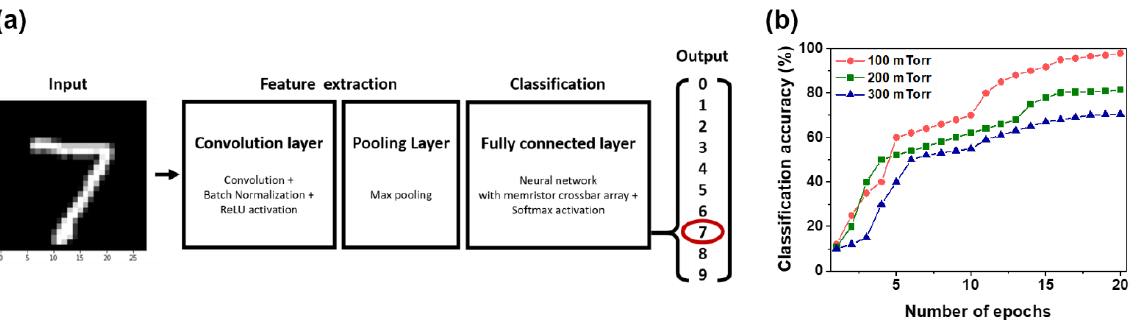
Figure 6. ( a ) Schematic diagram of the CNN structure and ( b ) calculated recognition accuracy of the MNIST patterns as a function of the number of training epochs for the PCMO memristors grown by varying the OP.